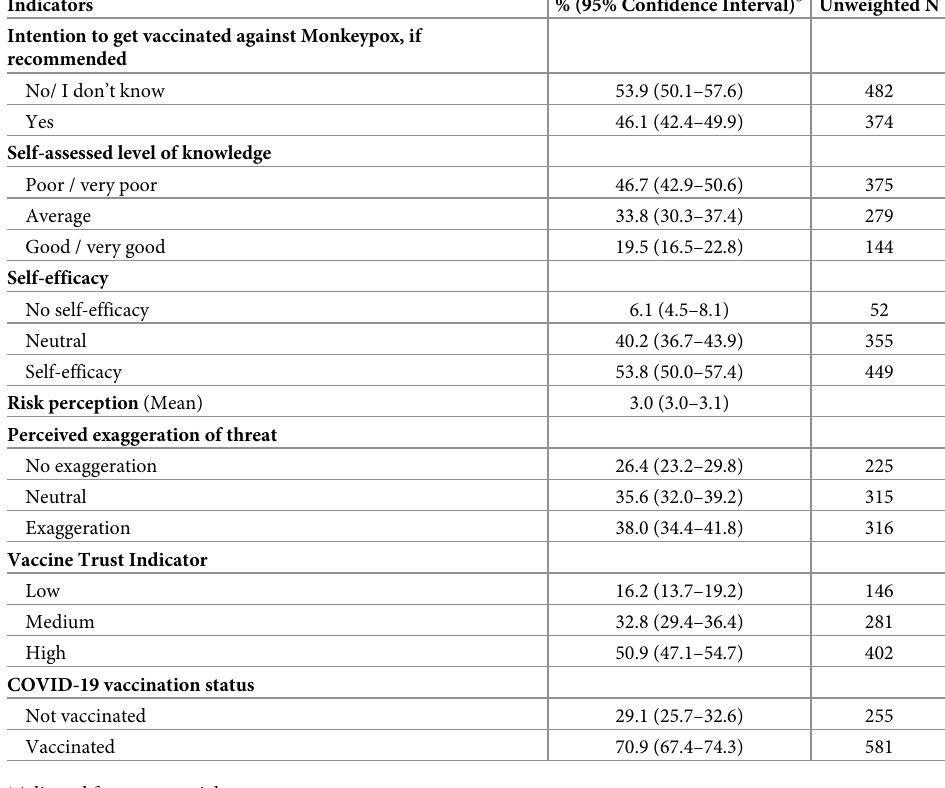
Table 2. Monkeypox knowledge, self-efficacy, risk perception, perceived exaggeration, Vaccine Trust Indicator and COVID-19 vaccination status.